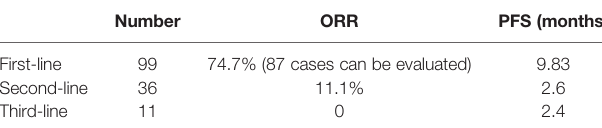
TABLE 1 | Patient characteristics. TABLE 2 | Response to chemotherapy in SCLC